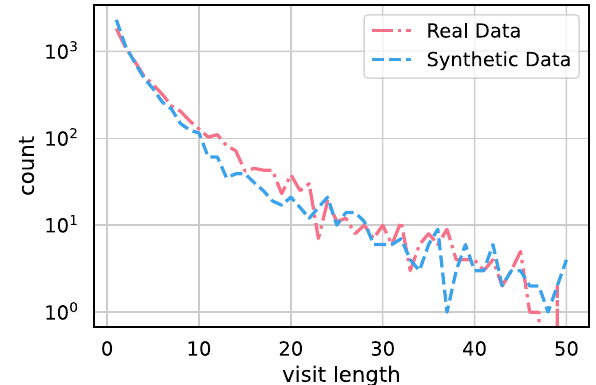
Fig. 8 Plot of visit lengths for real and synthetic data. The visit length refers to the number of Encounter nodes that exist in a patient trajectory. Only trajectories consisting of, at most, 50 Encounter nodes are considered.